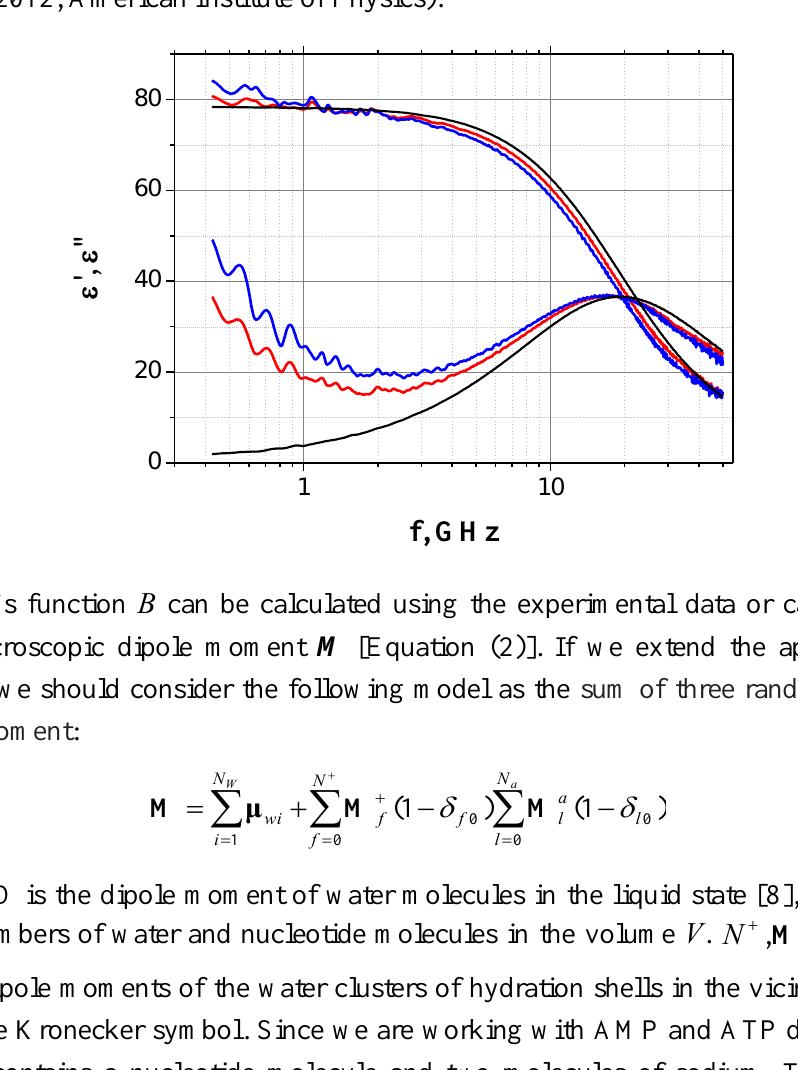
Figure 2. The real part ε ' ( f ) and the imaginary part ε '' ( f ) of the dielectric spectra (1021 frequency points) for water (black line), and for 0.06 mol/L aqueous solutions of AMP (red line) and ATP (blue line) at 25 °C. Reprinted with permission from reference [10], (Copyright 2012, American Institute of